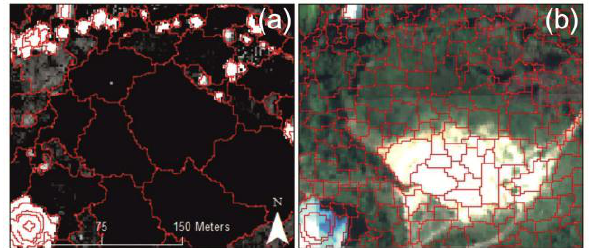
Figure 3. Segmentation based on CHM (a) creates segments based on their height and thus it does not differentiate between very low vegetation and bare soil. NDVI based segmentation separates the bare soil from the very low vegetation